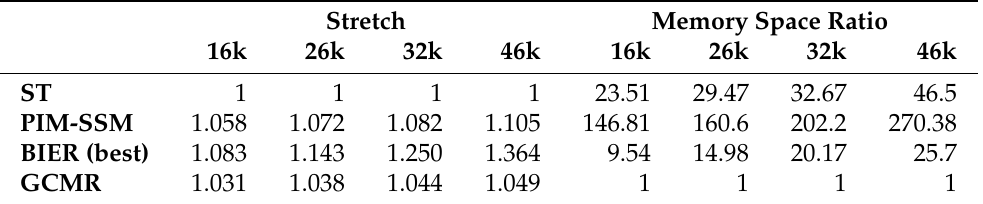
Table 1. Stretch and memory space consumption considering 2000 leaf nodes and the 16k, 26k, 36k and 46k